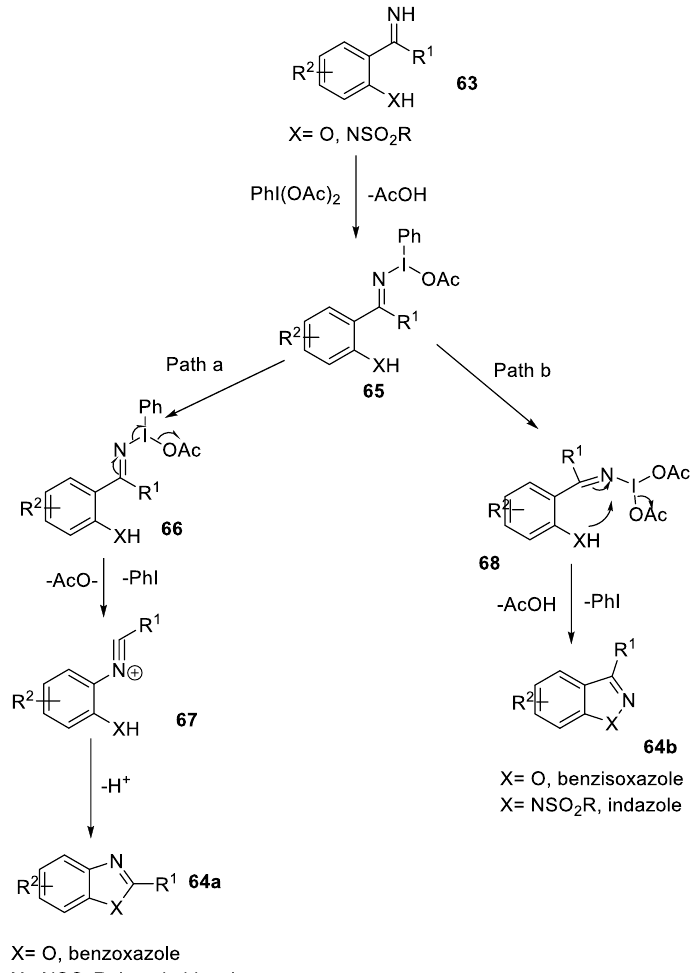
Figure 10. Plausible mechanism for synthesis of benzoxazoles and benzimidazoles.